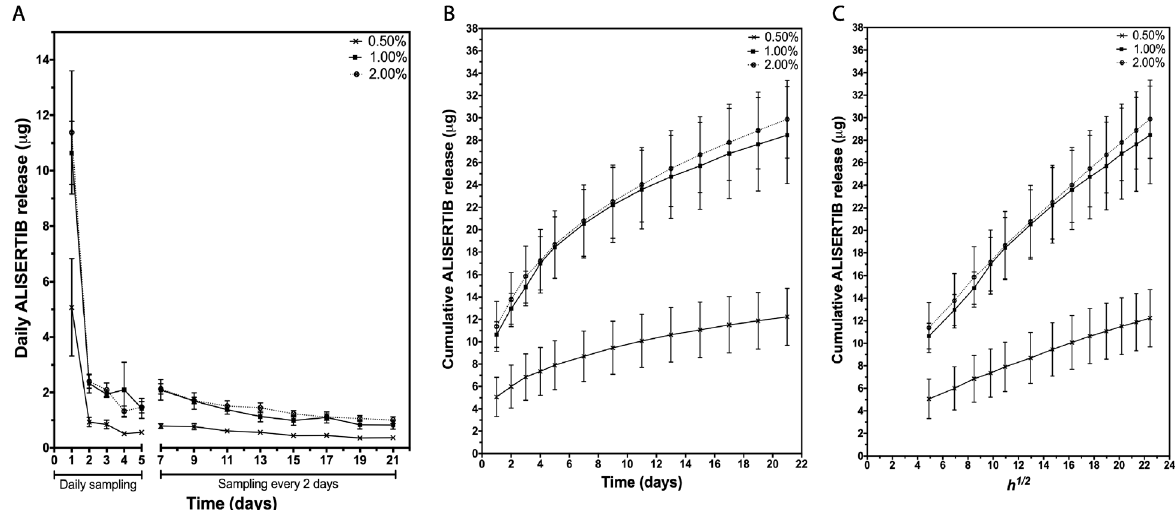
Fig 3. Alisertib is released from intravaginal rings in a controlled and sustained kinetic over 3 weeks in vitro . Mouse-sized rings loaded with various concentrations of ALISERTIB (0.5%, 1%, 1.5% and 2%) w/w were suspended in scintillation vials containing the release medium before incubating the rings individually in 50% isopropanol/water. Rings were then left in an orbital shaker at 37 ˚C and medium sampled every 24h for the first 5 days, and then every 48h for the remaining weeks. Mass of ALISERTIB release was measured by HPLC. (a) Daily ALISERTIB release versus time (days) (b) cumulative ALISERTIB release versus time (days) and (c) cumulative ALISERTIB release versus square root time (h 1/2 ) are plotted. Data is representative of the mean ± standard error of mean (SEM) of triplicate